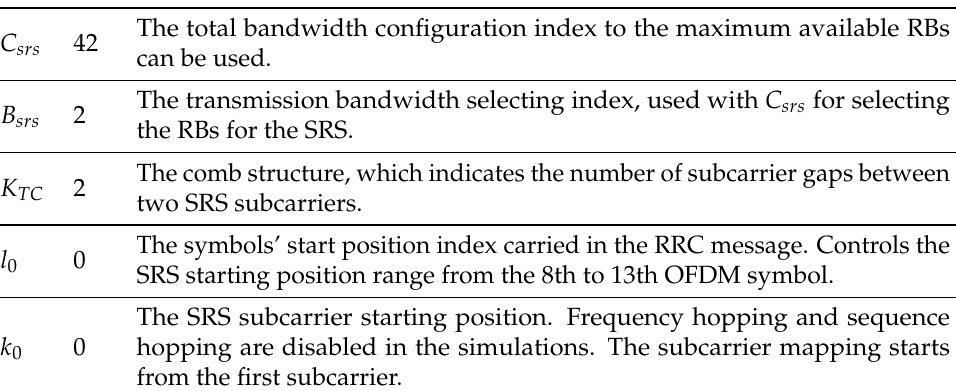
Table 2. SRS configuration. RB, resource block; RRC, radio resource